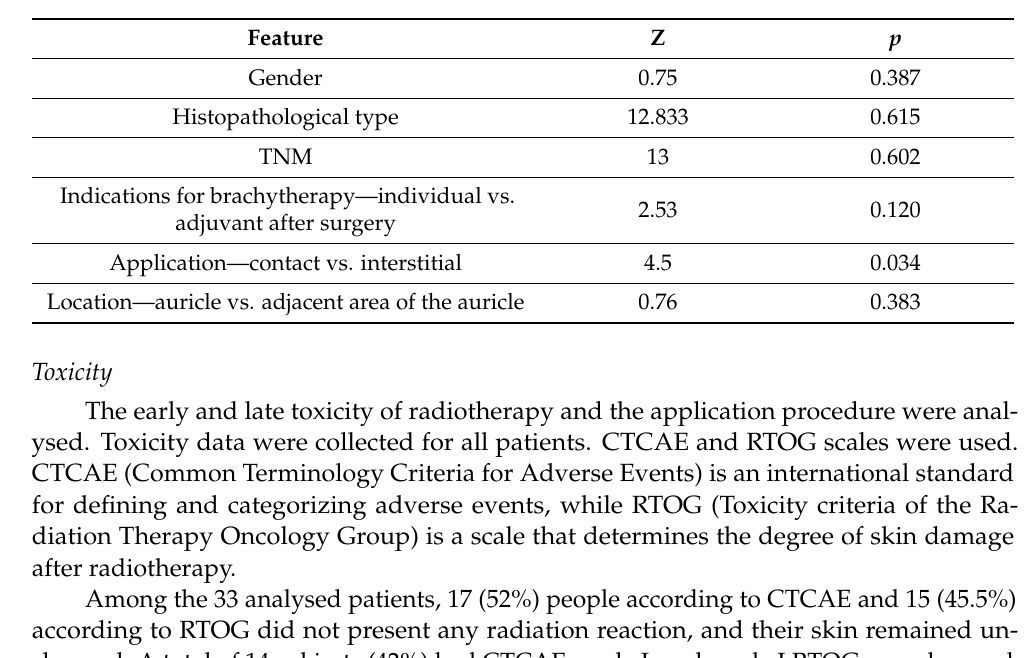
Table 5. Influence of selected factors on the severity of radiation reaction on the basis of the chi-square test. TNM—tumour, node,